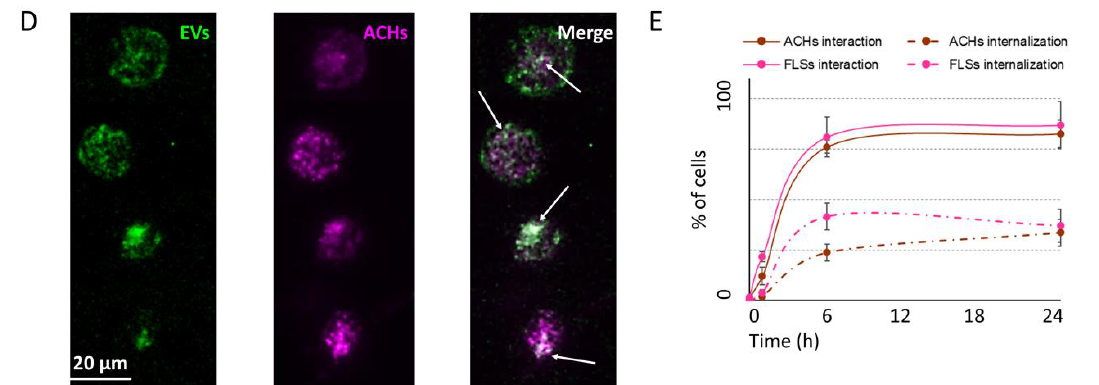
Figure 5. ASC-EV interaction with and incorporation in ACHs and FLSs over time in 3D microfluidic devices. ( A ) Pictures at time 0 and after 24 h of ACHs and FLSs grown in 3D chips and incubated with ASC-EVs. EVs were CFSE-stained and are shown in green, whereas cells were stained with CellTracker ™ Deep Red Dye and are shown in violet. The merged pictures clearly show the overlapping of the signal of ASC-EVs with cells. One representative donor is shown. ( B ) Green fluorescence intensity at di ff erent time points of ACHs and FLSs incubated or not with ASC-EVs inside the 3D microfluidic device. ( C ) The trend over time of mean green fluorescence of ACHs and FLSs incubated with ASC-EVs. N = 3, values are shown as mean ± SE. Significance for p -value < 0.05. ( D ) Representative pictures of ASC-EVs (green) incubated with ACHs (violet) after 24 h in 3D microfluidic device. EVs clearly surrounded ACHs and were also internalized, as indicated in the merge pictures by the white arrows. ( E ) Trend over time of the number of cells either interacting with ASC-EVs regardless outside or inside (continuous line) or with internalization (dashed line). N = 3, values are shown as mean ± SE. Significance for p -value < 0.05.